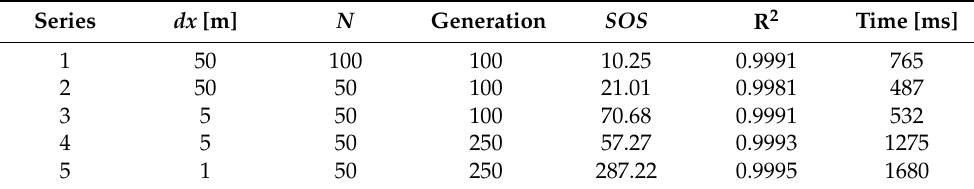
Table 2. Comparison of goodness of fit for different algorithm parameters.